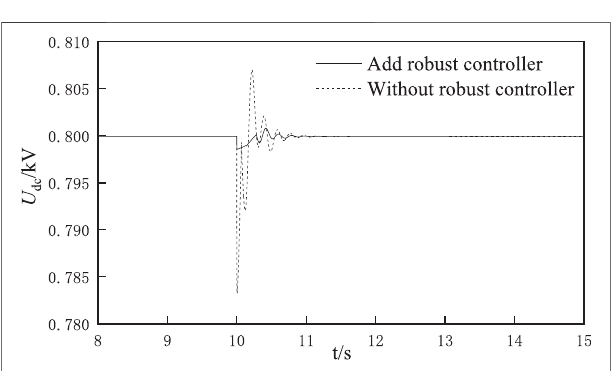
FIGURE 12 | DC bus voltage waveform when chopper K pi is